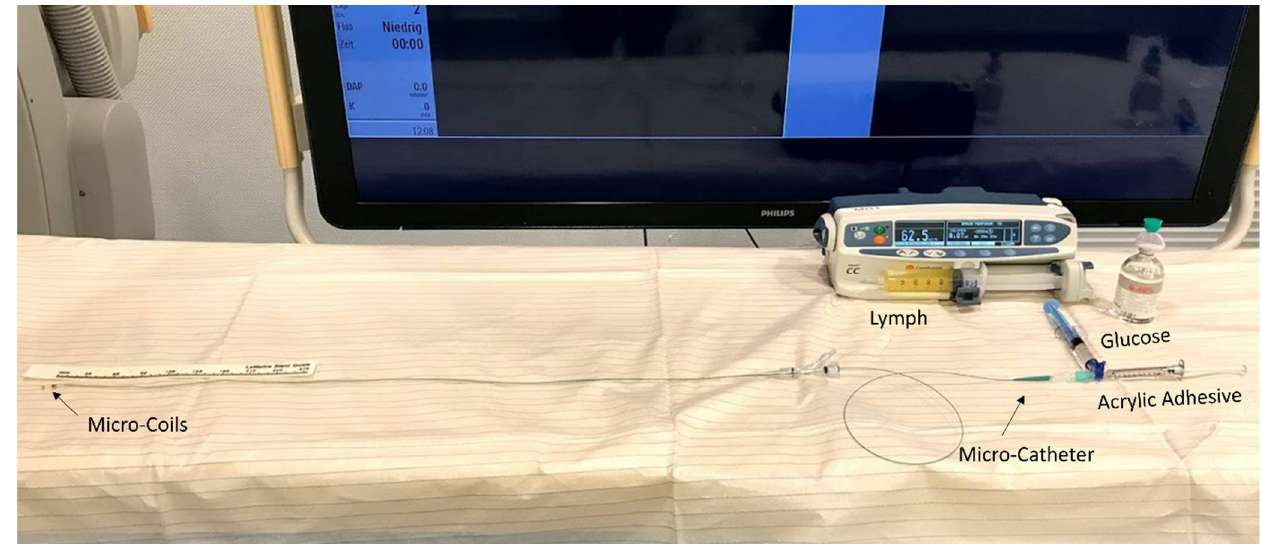
Figure 2. Basic testing setup for dynamic experiments: lymphatic fluid is continuously infused into a transfusion tube with microcoils placed within it. An acrylic adhesive mix with iodized oil is then applied into the tube via a microcatheter after flush-injection with 40% glucose. The catheter is then drawn back 10 cm while injecting embolic agent. The time until cessation of lymphatic flow (pressure increase > 60 mmhg) as well as the adhesive migration distance is measured.